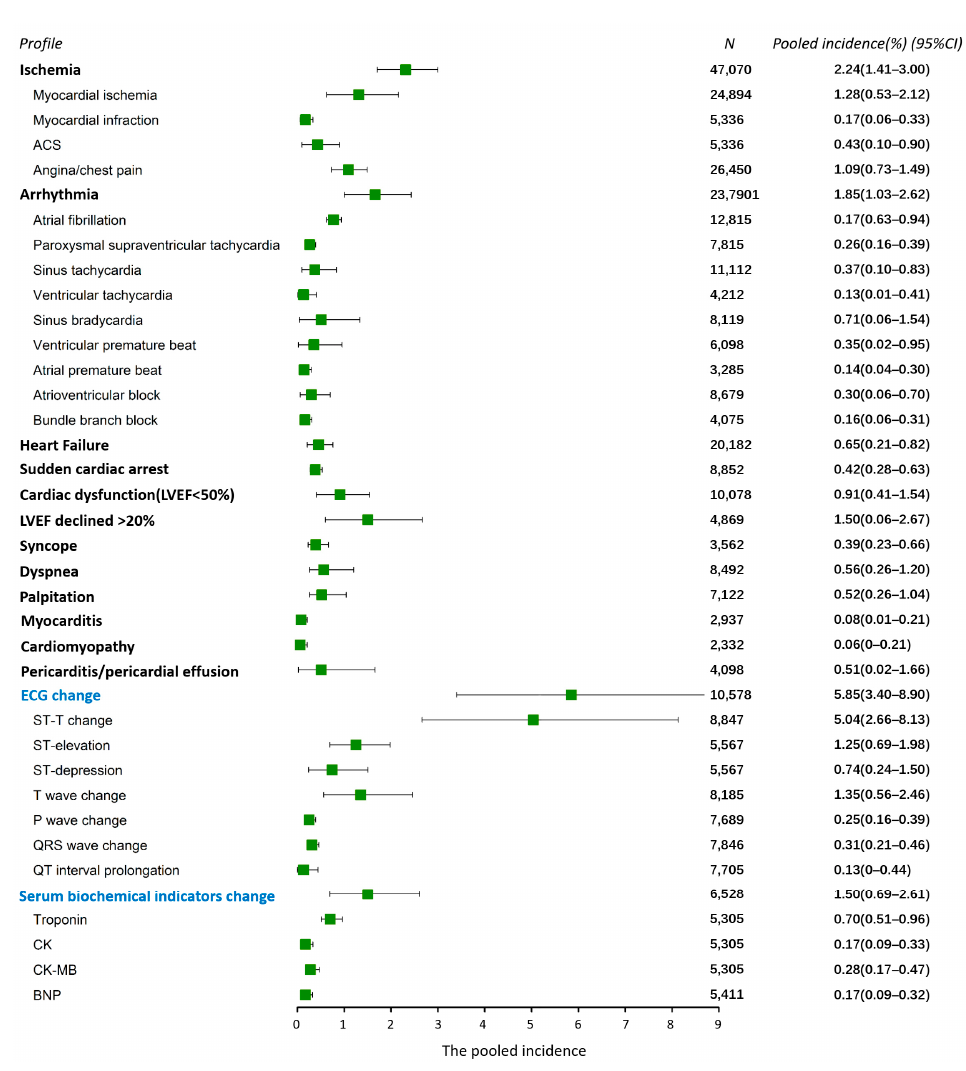
Figure 3. The profile of the FAC (all-grade cardiac AEs). Each bar and square represent the pooled value of incidence and 95% confidence interval for one cardiac AE. Vertical line indicates the overall incidence of all-grade adverse events (5.04%). Abbreviations: ACS, acute coronary syndrome; LVEF, left ventricular ejection fraction; CK, creatine kinase; BNP, B-type natriuretic peptide. “ N ” at the top of this figure represents the number of patients included in the evaluation for each AE.